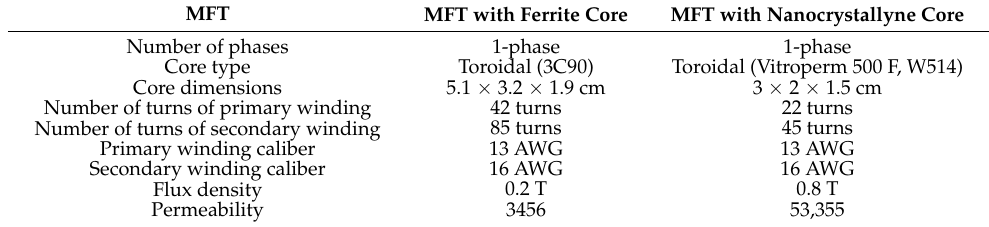
Table 9. Construction parameters of the